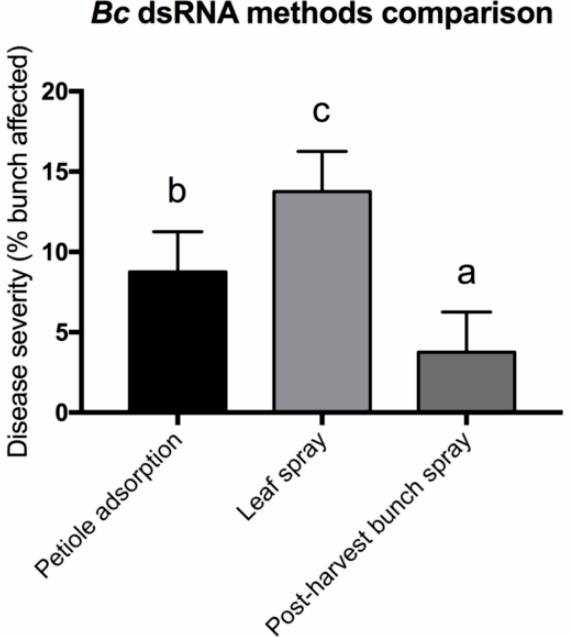
Figure 6. Comparison of disease severities among application methods used in this study using Bc dsRNAs. Different lowercase letters above bars indicate significant differences as determined by Tukey HSD test ( p ≤ 0.05).